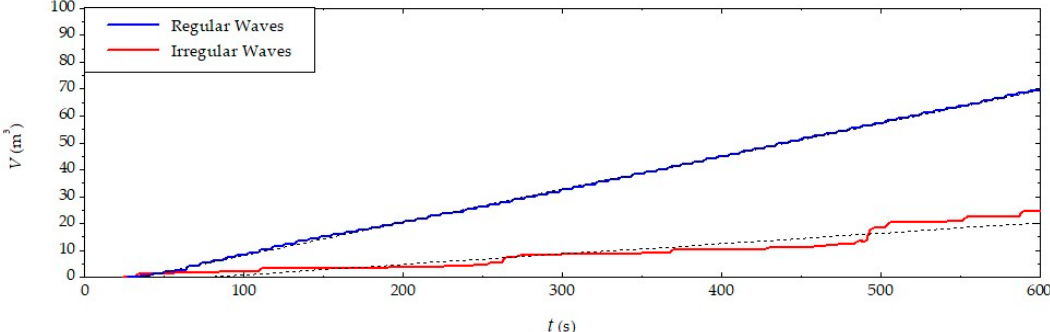
Figure 17. Volume of water accumulated in the reservoir over time due to the incidence of the representative regular waves and realistic irregular waves for SVP.